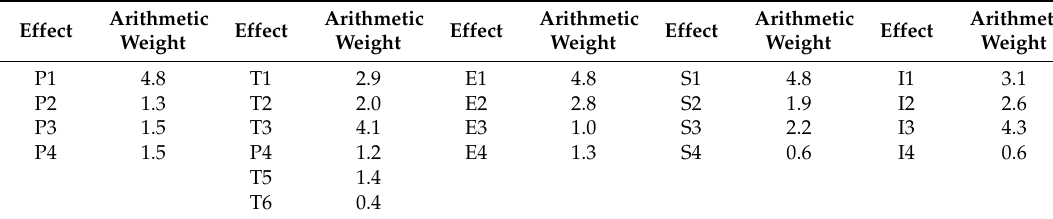
Table 2. The arithmetic weight of the effects of